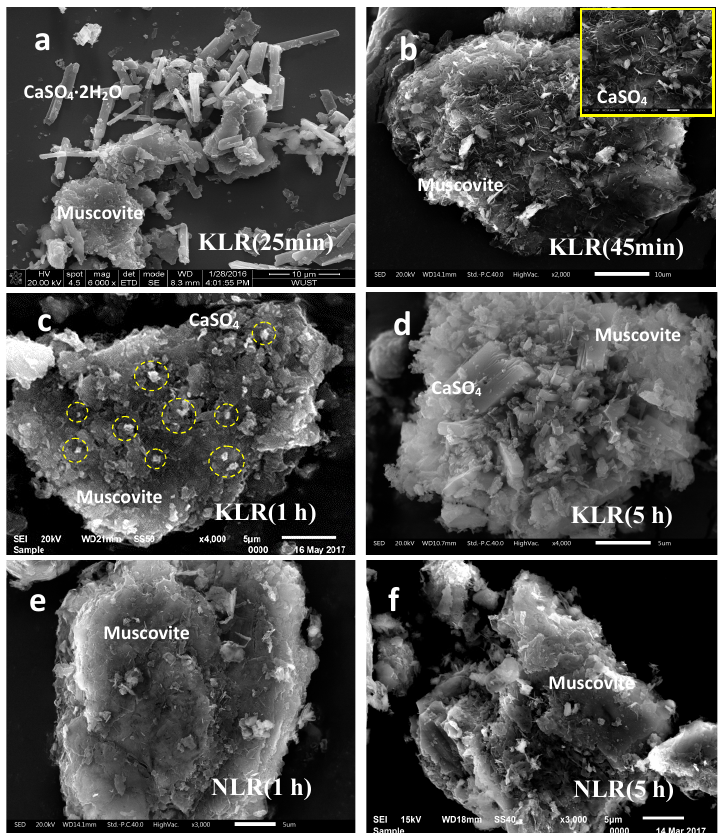
Figure 8. SEM patterns of the K 2 SO 4 -assisted leaching residues (KLR) obtained from leaching with 4 mol / L H 2 SO 4 and 7wt% K 2 SO 4 for ( a ) 25 min (100 ◦ C), ( b ) 45 min (150 ◦ C), ( c ) 1 h (150 ◦ C), and ( d ) 5 h (150 ◦ C) and the non-assisted leaching residues (NLR) obtained from contrast leaching with 4 mol / L H 2 SO 4 for ( e ) 1 h (150 ◦ C) and ( f ) 5 h (150 ◦ C).